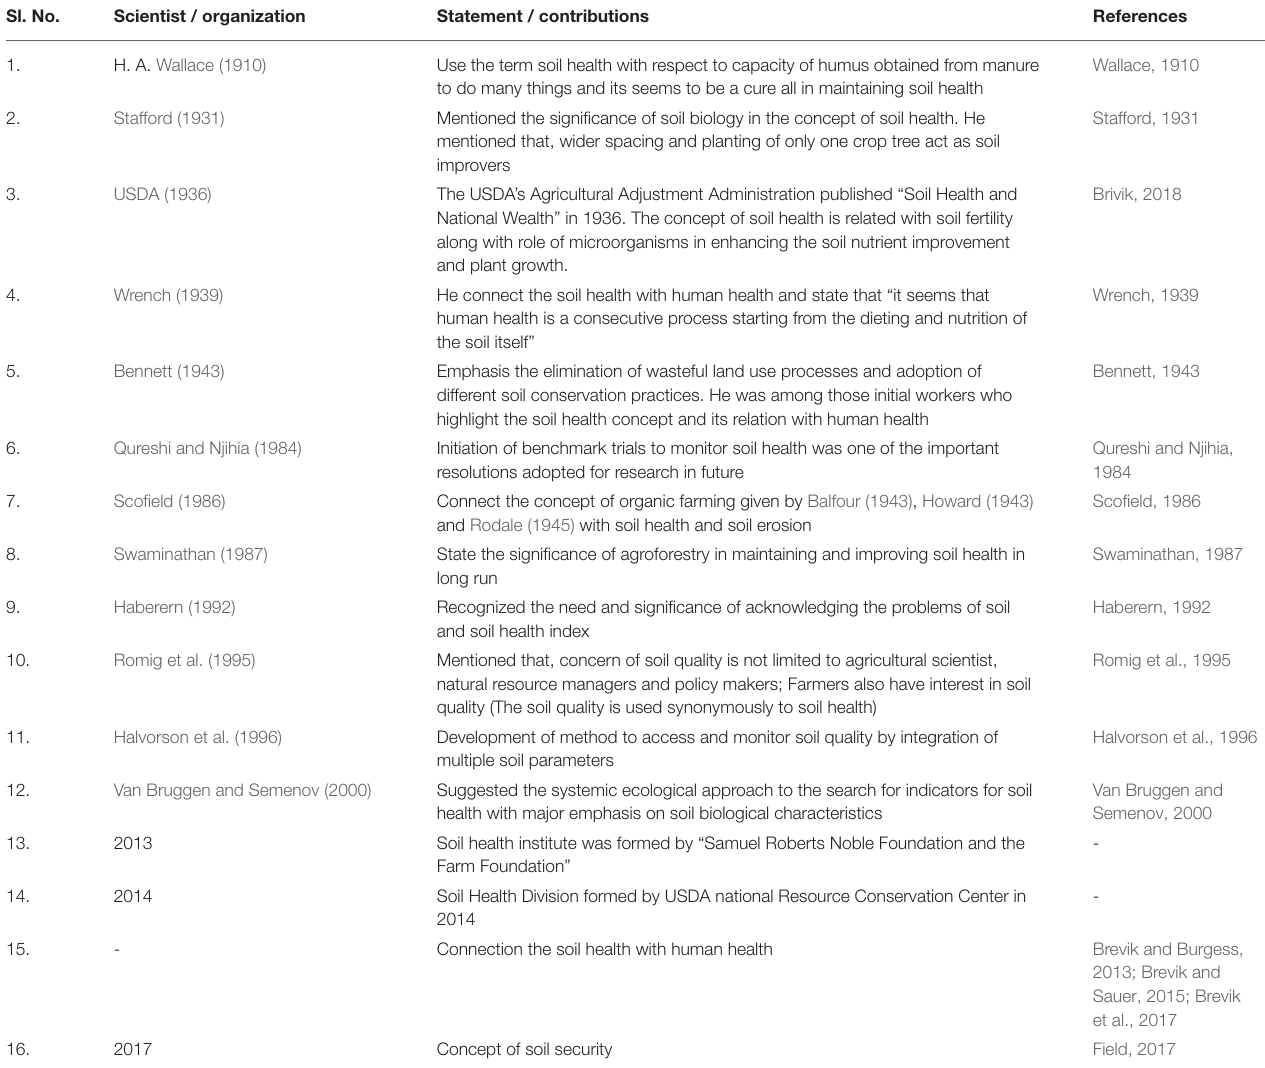
TABLE 2 | Historical development of the concept of soil health. Sl.